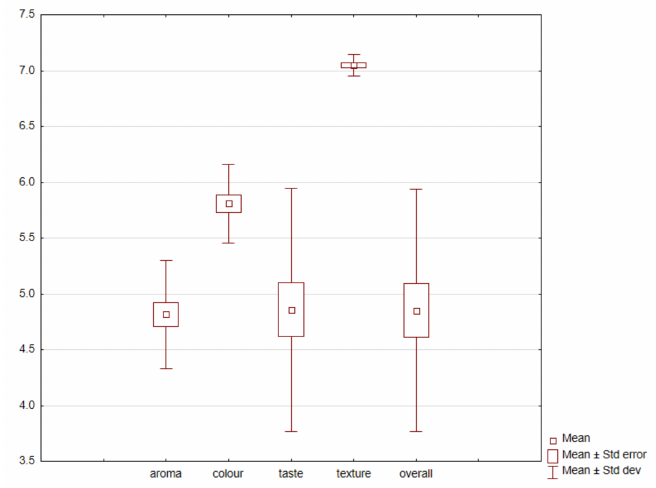
Figure 1. Box plot diagram of consumer desirability (colour, taste, aroma, texture, and overall desir- ability) of extruded snacks depending on the addition of fermented red or broad bean seeds/hulls and herbs/species (0.5%).